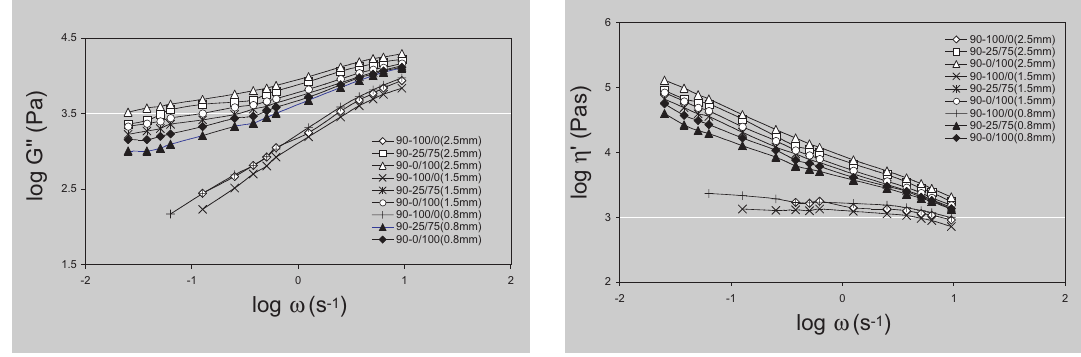
Figure 12 (left): Loss modulus, G’’, as a function of angular frequency, w , for composites having different thickness and composition at q = ± 1°. Figure 13 (right): Dynamic viscosity, h ’, as a function of angular frequency, w , for composites having different thickness and composition at q = ±